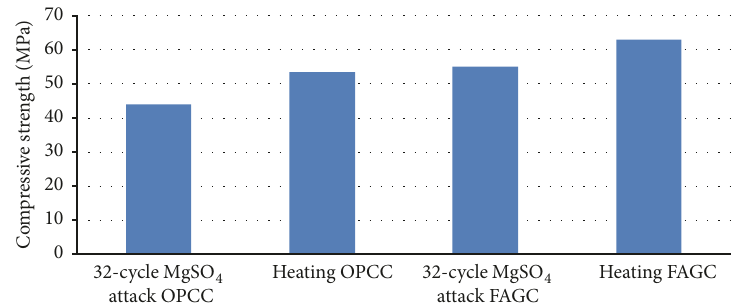
Figure 5: Compression strength of OPCC and FAGC specimens in the 32-cycle MgSO 4 attack and heating group.